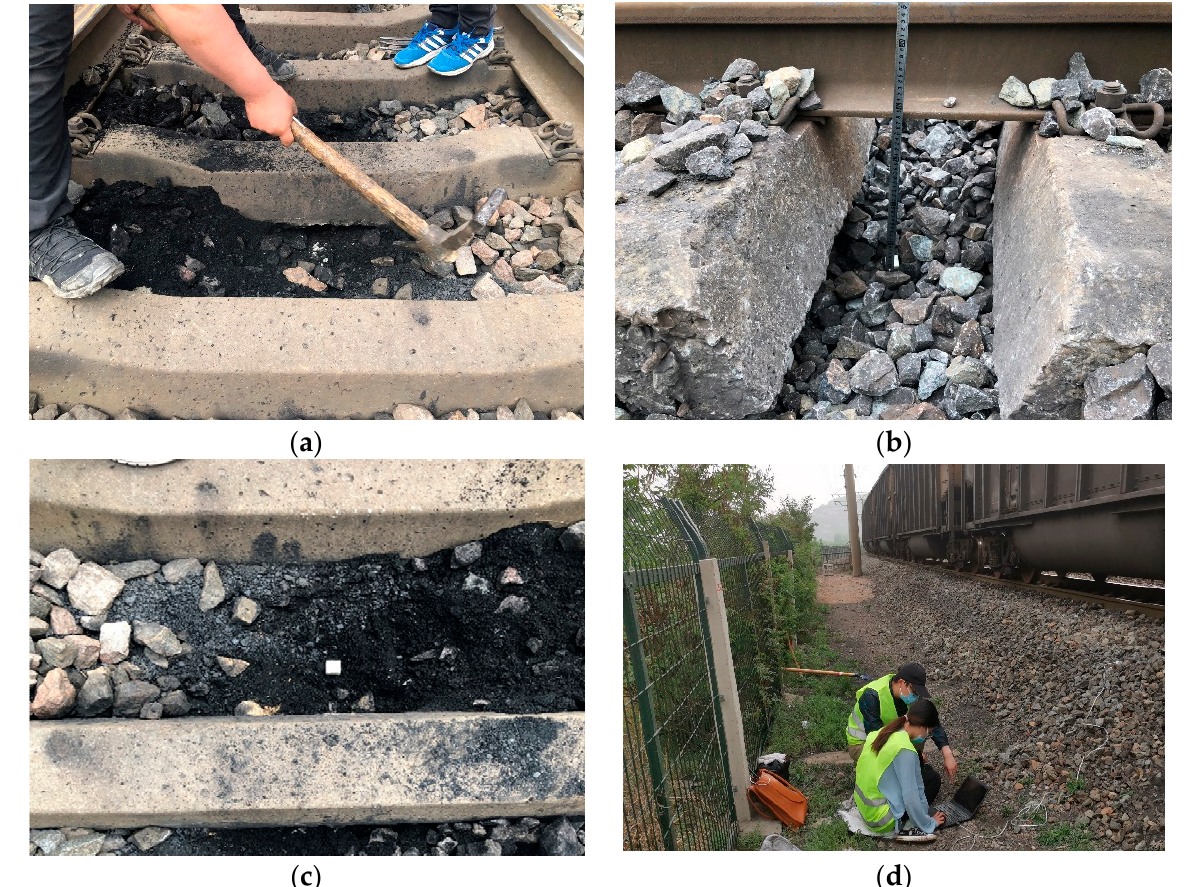
Figure 7. Field Installation sequences of the SR sensors: ( a ) Instrumentation excavation; ( b ) Sensor placement; ( c ) Ballast backfill; ( d ) Data acquisition